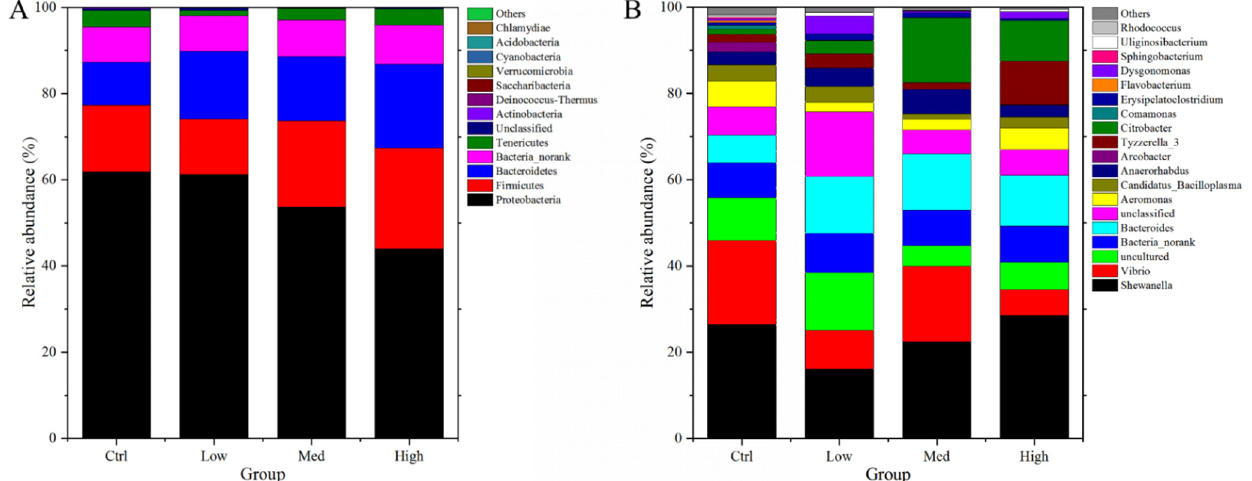
Figure 9. The influences of Hg exposure on intestinal microbiome composition at phyla and genera level: ( A ) Relative abundances of the dominant bacteria at phyla level among the four Hg exposure groups. ( B ) Relative abundances of the dominant bacteria at genera level among the four Hg exposure groups. Ctrl: 0 μ g/L Hg 2+ ; Low: 8.75 μ g/L Hg 2+ ; Med: 21.875 μ g/L Hg 2+ ; High: 43.75 μ g/L Hg 2+ .